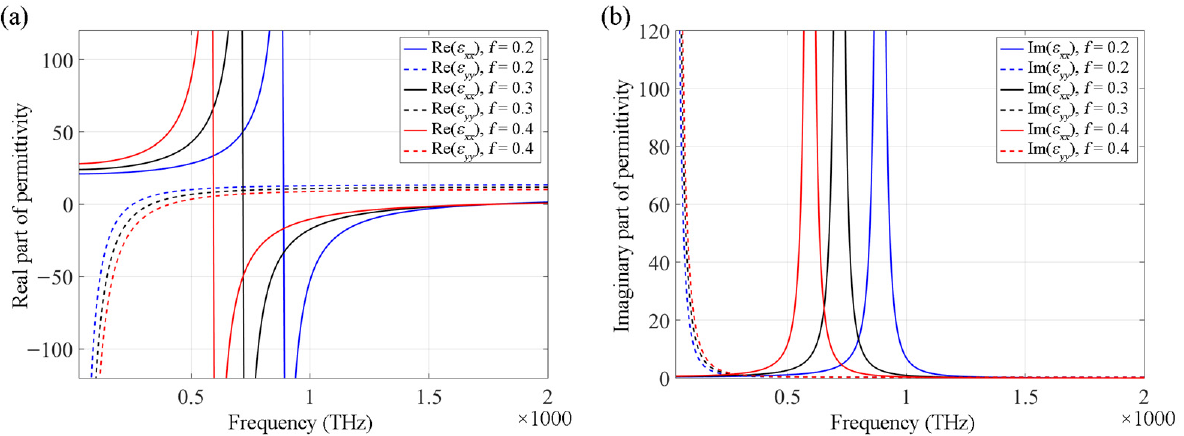
Figure 2. Transverse (solid line) and longitudinal (dashed line) components of effective permittivity of HMMs with different filling factors of f = 0.2 (blue), f = 0.3 (black) and f = 0.4 (red), respectively, at different frequencies. ( a , b ) show the real and imaginary parts of the effective permittivity, respectively.